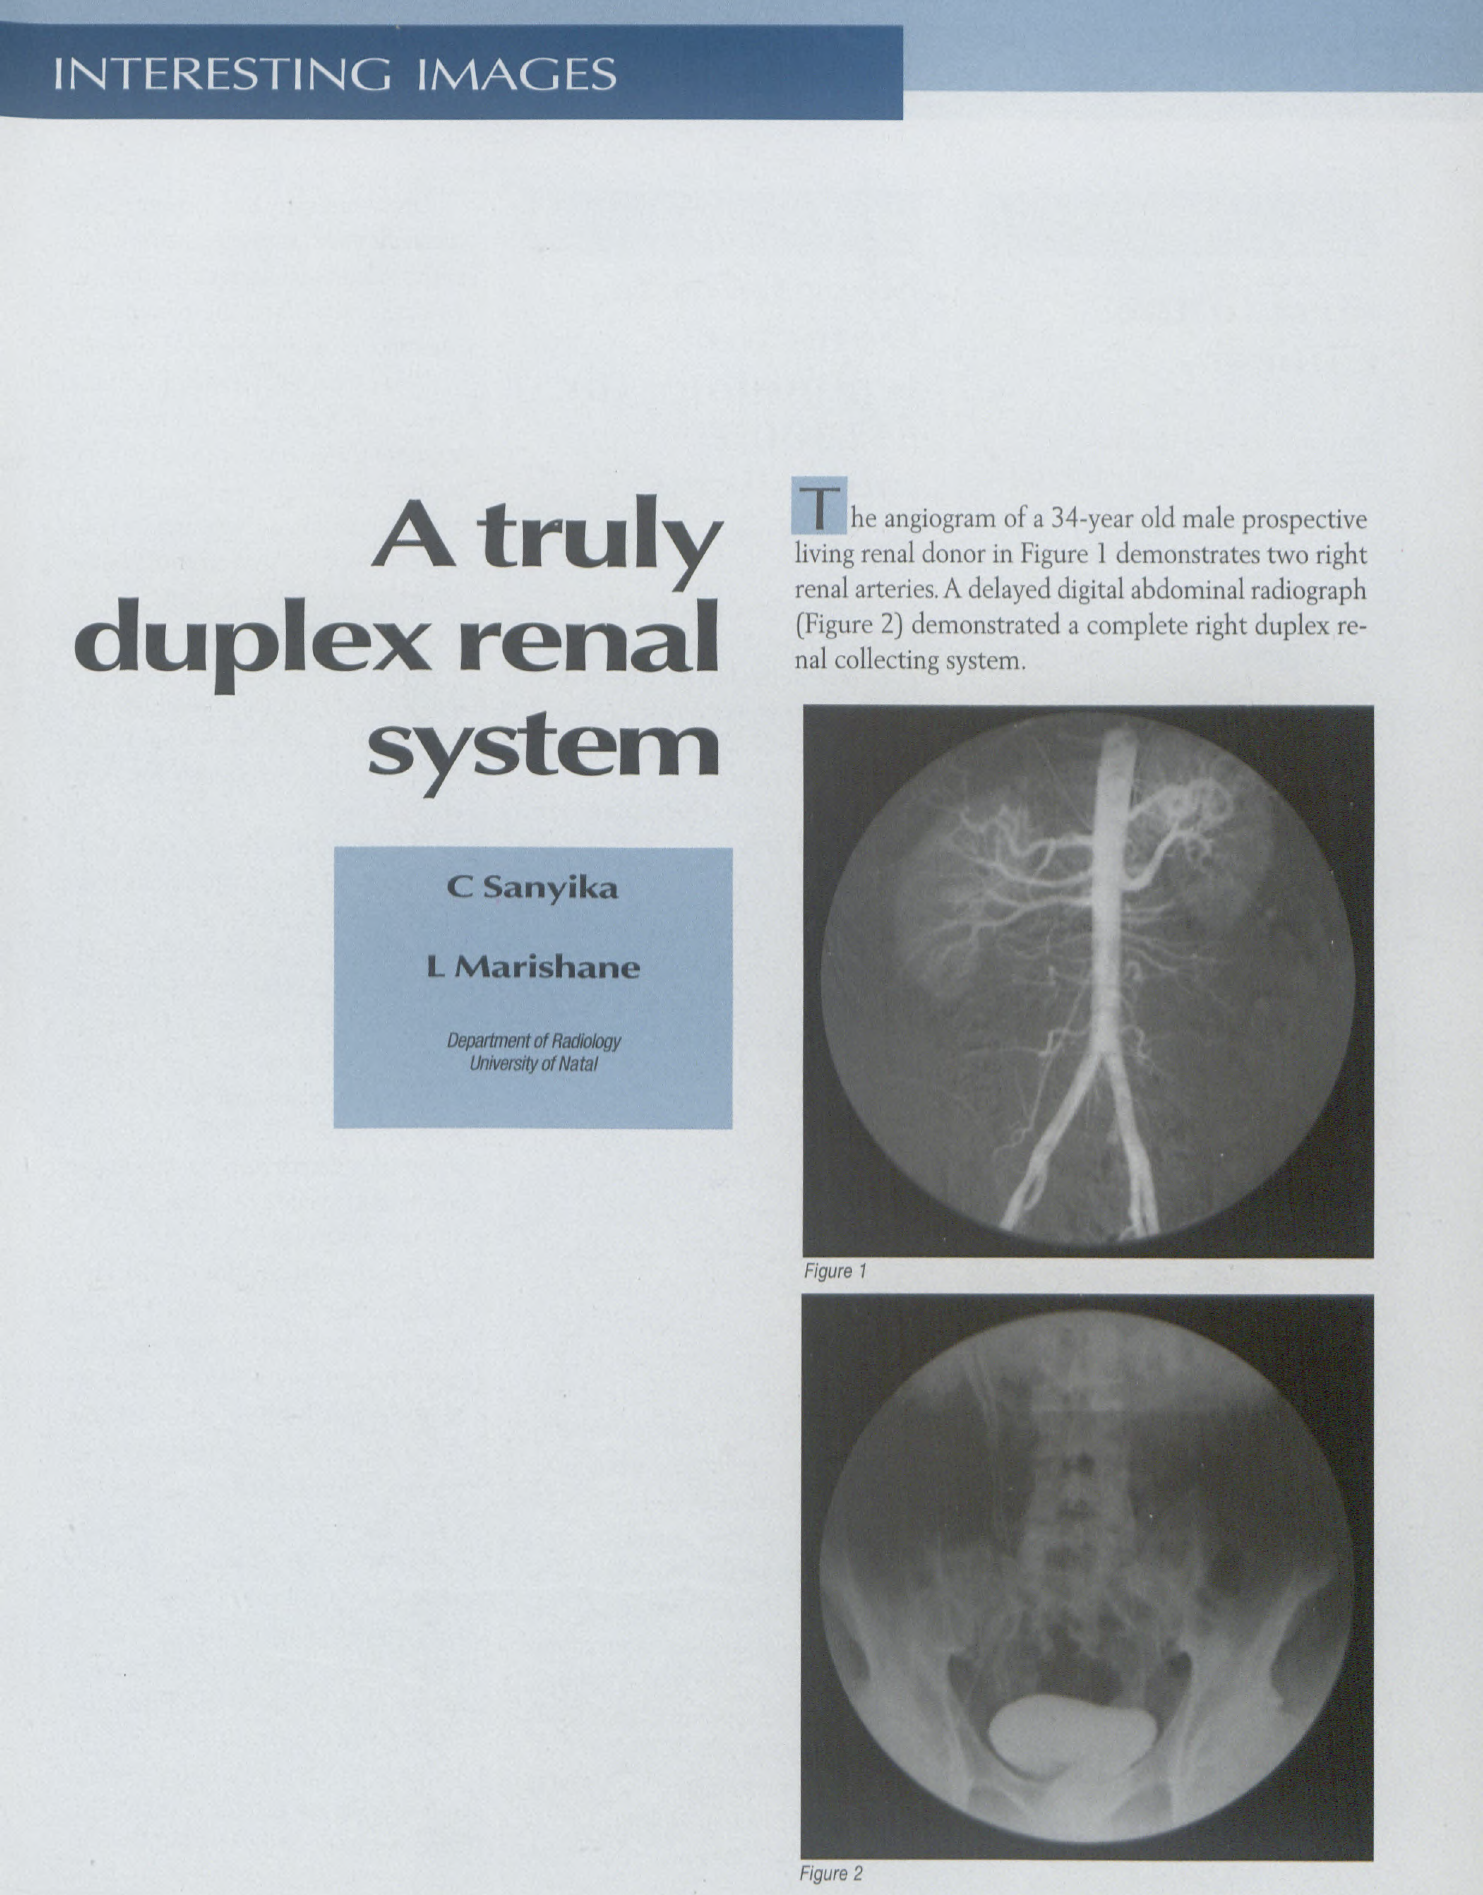
T he angiogram of a 34-year old male prospective living renal donor in Figure 1 demonstrates two right renal arteries. A delayed digital abdominal radiograph (Figure 2) demonstrated a complete right duplex re- nal collecting